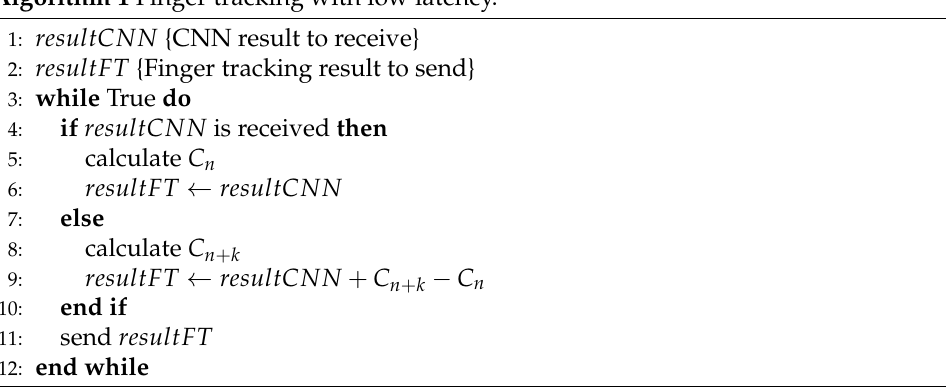
Algorithm 1 Finger tracking with low latency.